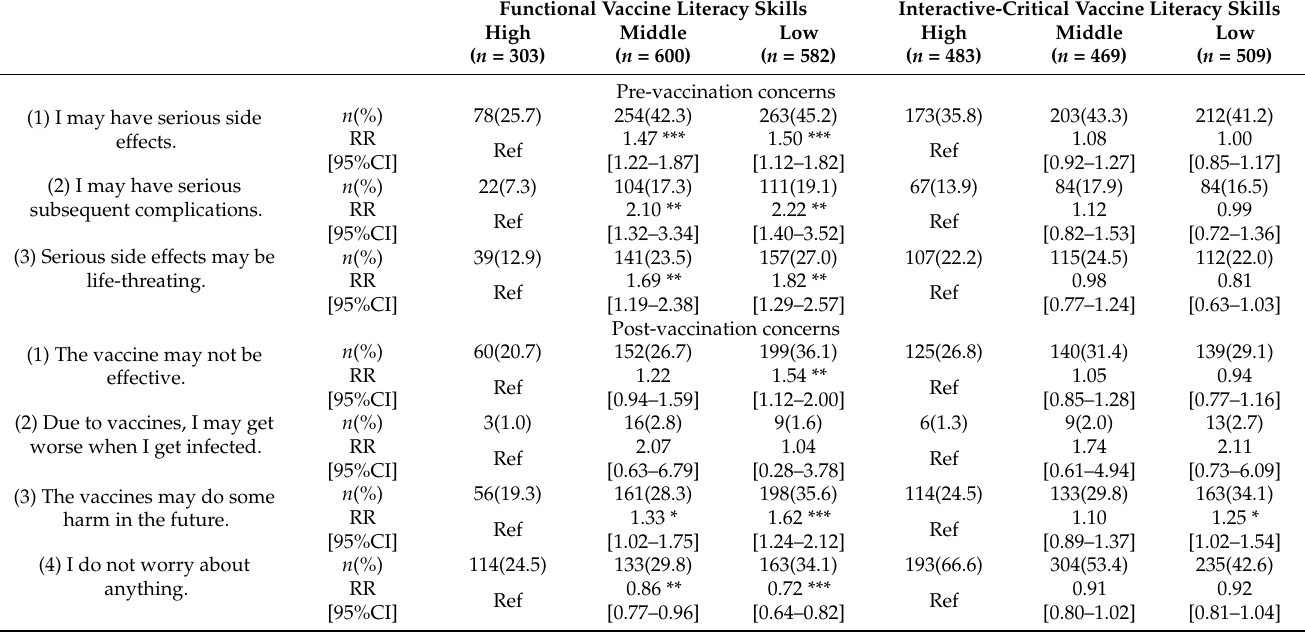
Table 2. Pre-/post-COVID-19 vaccination concerns and intentions to recommend the COVID-19 vaccine to others for each vaccine literacy (functional and interactive-critical) level